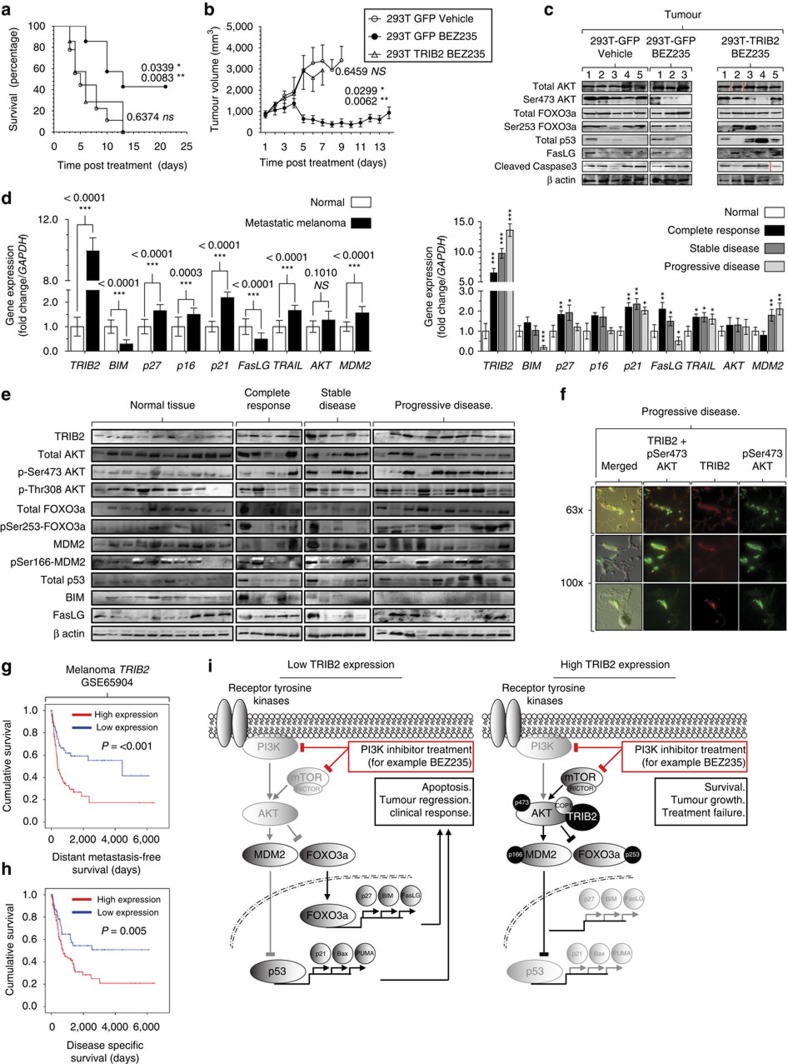
TRIB2-conferred resistance to PI3K inhibitors in vivo and ex vivo and correlates with poor clinical prognosis.(a) Kaplan–Meier analysis of isogenic TRIB2 cell lines grow subcutaneously in NOD/Scid mice treated with vehicle (n=7), of BEZ235 (n=7). The presence of TRIB2 significantly reduced survival (log rank P=0.033) when treated daily with BEZ235. (b) TRIB2 overexpressing 293T tumours (n=7) show little to no response to daily administration of BEZ235 compared to isogenic lines with endogenous (low, n=7) TRIB2 expression. (c) Representative immunoblot analysis of key proteins of interest from in vivo treated tumours. Only three tumours were present from the 293T-empty-BEZ235 treatment group. Red line (on 293-TRIB2 treated immunoblots highlight bands from the same membrane that were spliced due to lane gaps left on the original full immunoblot. Original full membranes are provided in Supplementary Information; Supplementary Fig. 19). (d) (left panel) Quantitative real time PCR (qRT-PCR) analysis of gene expression in ex vivo metastatic melanoma samples (n=20) versus normal control tissue (n=10). Data were analysed by two-way ANOVA) and values represent the mean±s.d. (right panel), Quantitative real time PCR (qRT-PCR) analysis of gene expression in ex vivo metastatic melanoma samples (n=20) versus normal control tissue (n=10) classified by clinical response to first line chemotherapy (complete response n=5, stable disease n=5 or progressive disease n=10). Data were analysed by two-way ANOVA) *P≤0.05, **P≤0.01, ***P≤0.001) and values represent the mean±s.d. (e) Representative immunoblot analysis of the AKT signalling cascade from ex vivo metastatic melanoma samples compared to normal tissue samples. (f) Representative immunofluorecent images of metastatic melanoma dual stained for TRIB2 and pSer473-AKT1 demonstrating co-staining and interaction. (g) Kaplan–Meier analysis from melanoma patients in the GSE65904 dataset classified based on low (≥1.5 fold) or high (≥2.5 fold) TRIB2 expression. Log-rank tests reveal that TRIB2 expression is highly significant for patient prognosis with median survival for low (4,450 days) and high (394 days) expression respectively. (h) Kaplan–Meier analysis for metastasis-free survival based on low (≥1.5 fold) or high (≥2.5 fold) TRIB2 expression (i) Proposed model of TRIB2-mediated drug resistance.